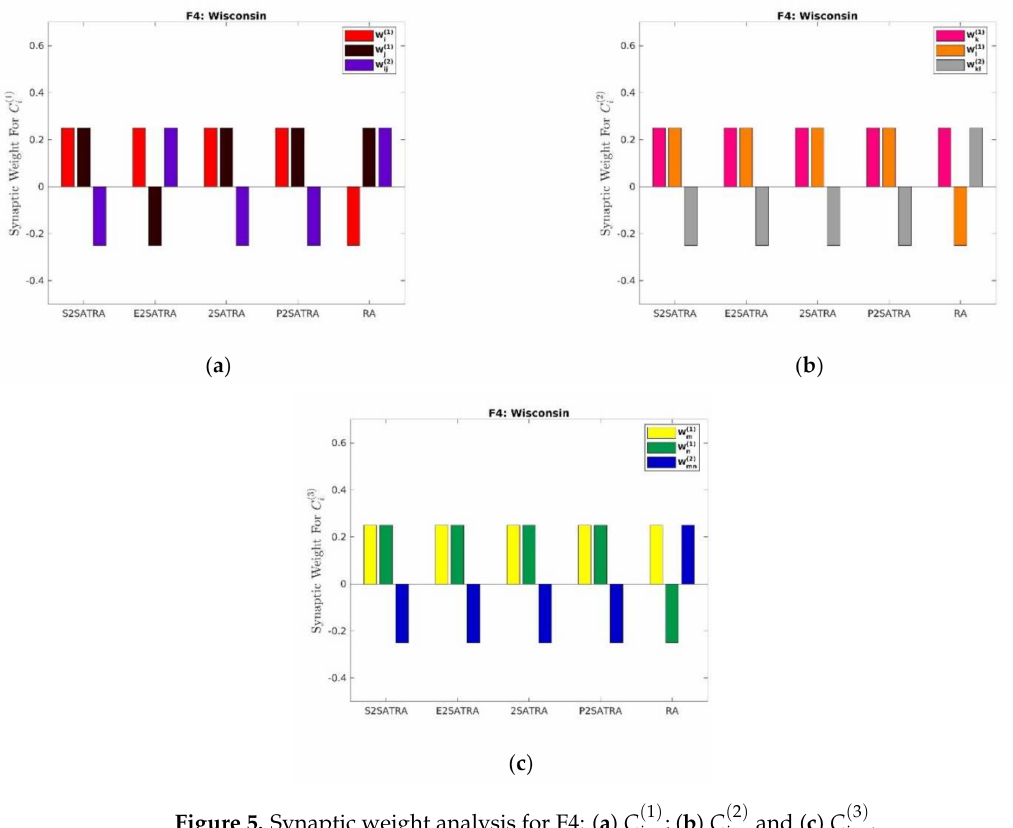
Figure 5. Synaptic weight analysis for F4: ( a ) C